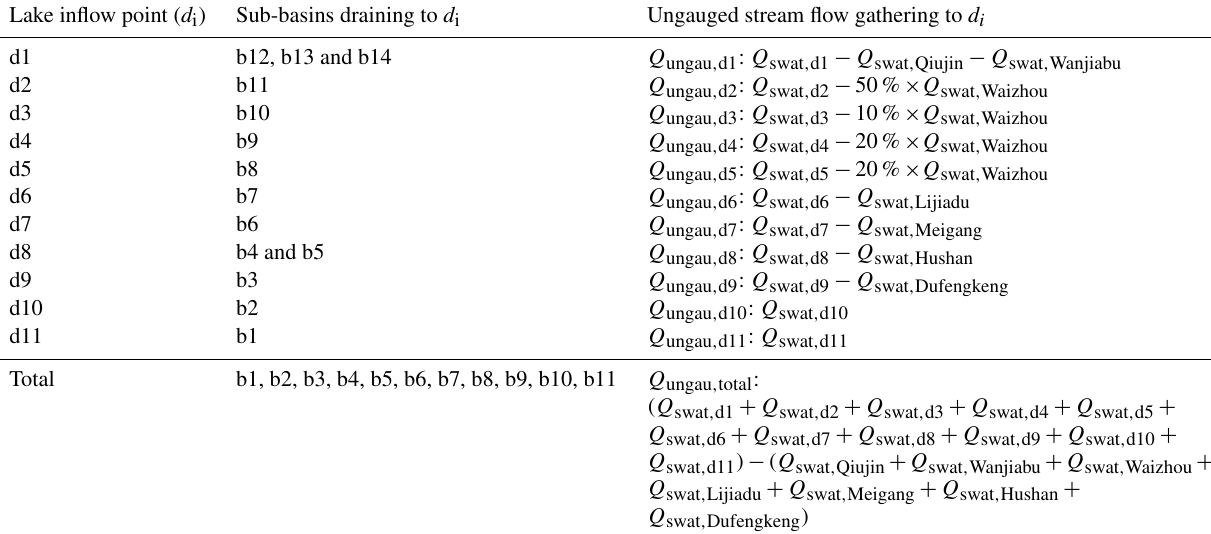
Table 2. The ungauged stream flow allocated to the lake inflow points of the dynamic model in the adjusted scenario. Q ungau ,d sents the ungauged stream flow gathering to the inflow points of d i . d1, d2, d3 ... d11 are the inflow points in the Delft3D model and the outlets in the SWAT model (Figs. 1b and 3). b1, b2, b3 ... b11 are the sub-basins in the PLUZ (Fig. 3b). Q swat ,d discharges at the outlet (di) from the SWAT model. Q swat , Qiujin , Q swat , Wanjiabu , Q swat , Waizhou , Q swat , Lijiadu , Q swat , Meigang , Q swat , Hushan , and Q swat , Dufengkeng represent the simulated discharges at the outlets of Qiujin, Waizhou, Lijiadu, Meigang, Hushan, and Dufengkeng, respectively, from the SWAT